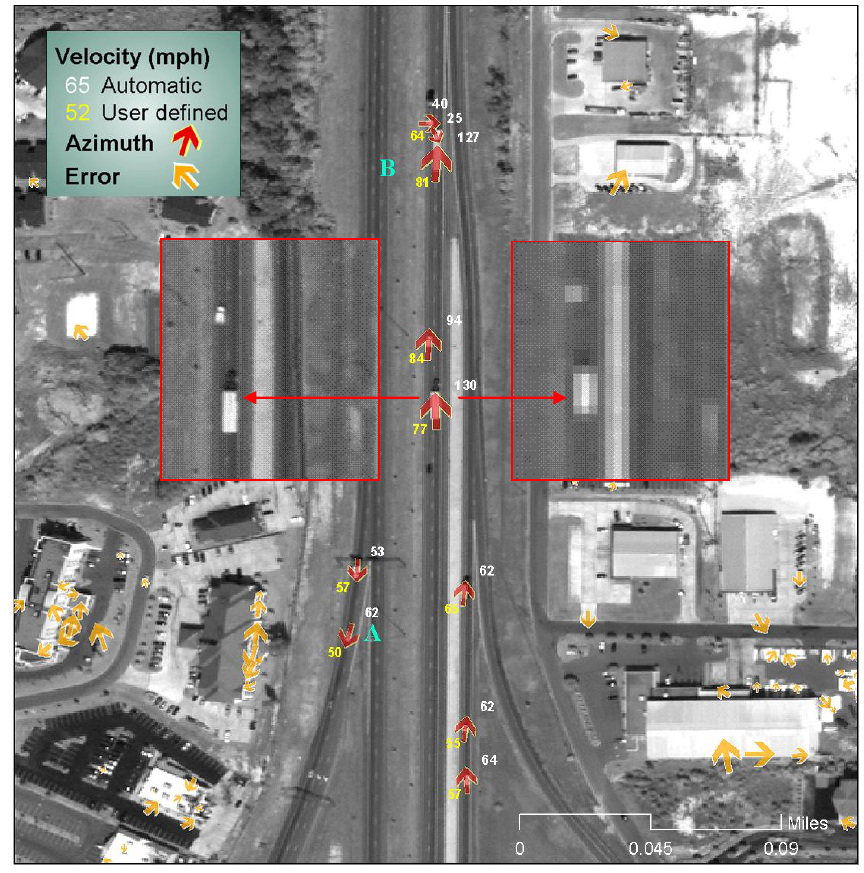
Figure 4. Study area displaying spatio-temporal attributes of moving targets. Speed annotation in miles per hour. Arrows display direction of target travel; red arrows overlie confirmed moving targets and yellow arrows represent likely error. Zoomed areas illustrate the feature size difference between panchromatic and multi-spectral scenes.